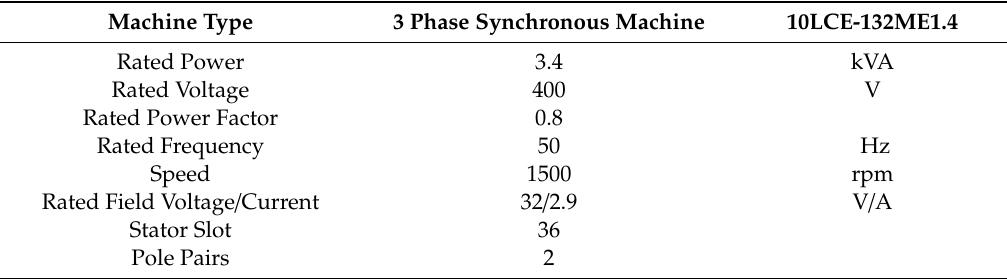
Table A1. Rating of the synchronous